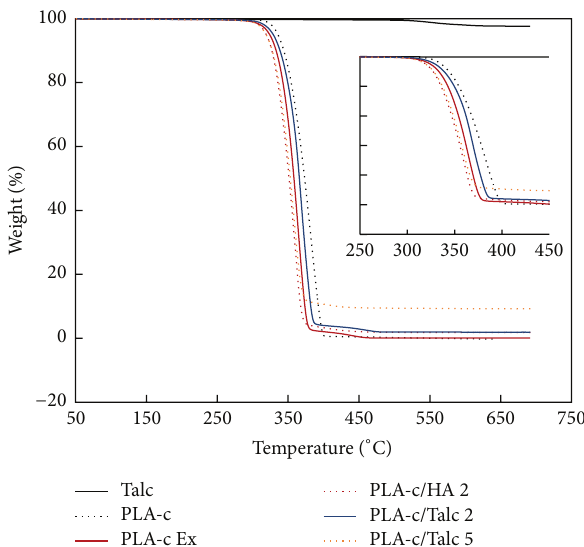
Figure 2: TGA results of PLA/HA and PLA/talc